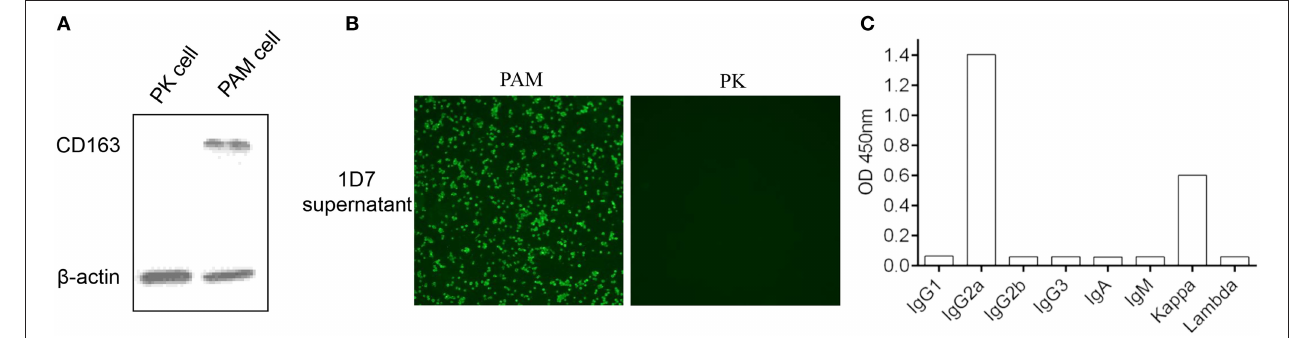
FIGURE 2 | Confirmation of the specificity of mAb 1D7. (A) . 1D7 was used for the analysis of endogenous CD163 expression of porcine AMs and PK cells with western blotting. (B) Immunofluorescence was used to analysis the specific of 1D7 mAb. (C) . Subtype identification of 1D7 with a mouse antibody subtype identification